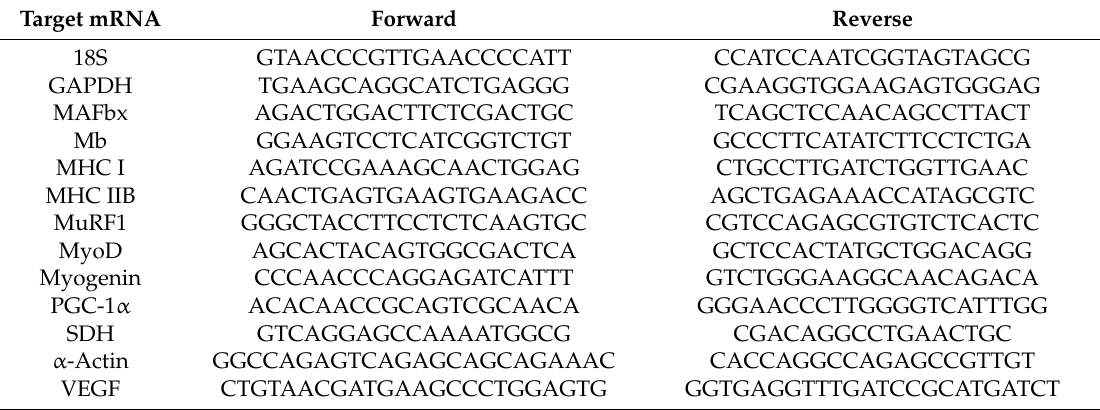
Table 1. Primers used for PCR analysis. GAPDH glyceraldehyde-3-phosphate dehydrogenase; MAFbx muscle atrophy F-box; Mb Myoglobin; MHC Myosin Heavy Chain; MuRF1 muscle RING finger 1; PGC-1 α peroxisome proliferator-activated receptor- γ coactivator-1 α ; SDH succinate dehydrogenase; VEGF vascular endothelial growth